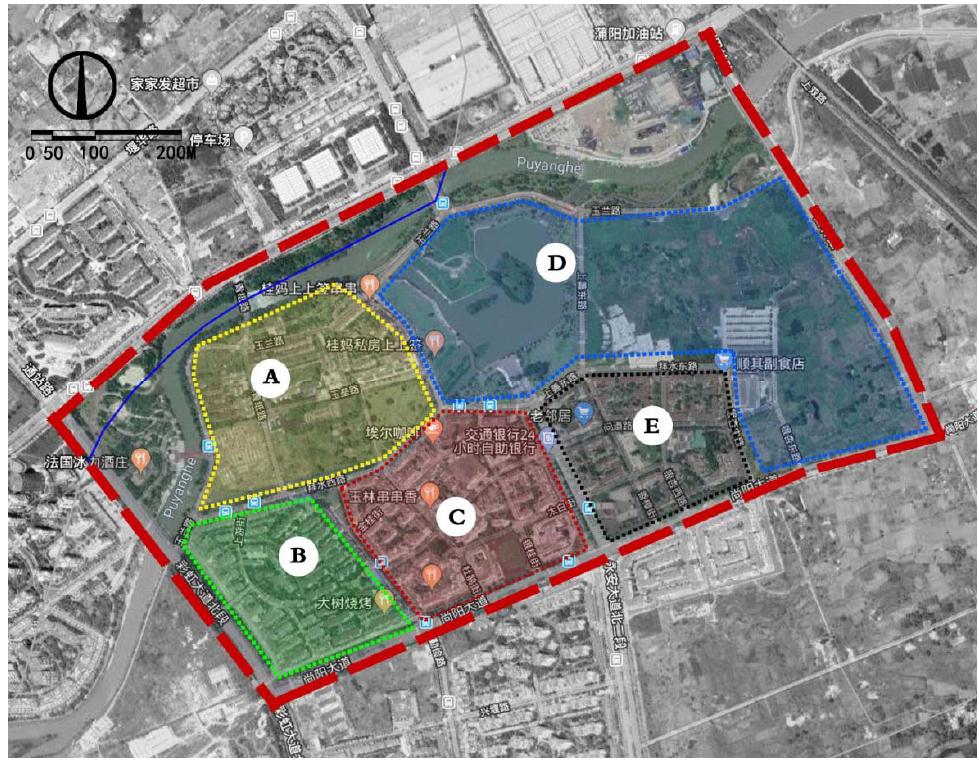
Figure 3. Research area division.